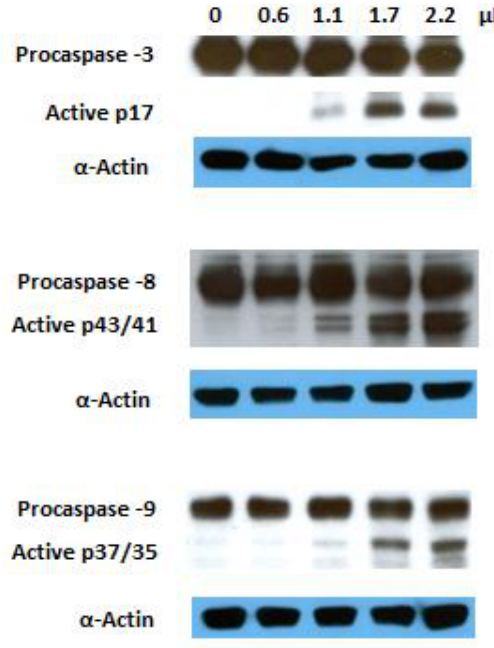
Figure 6. Effect of compound 10 on the activation of caspases 3, 8, and 9 in Jurkat cells after 6 h of treatment; α -actin was used as a loading control.